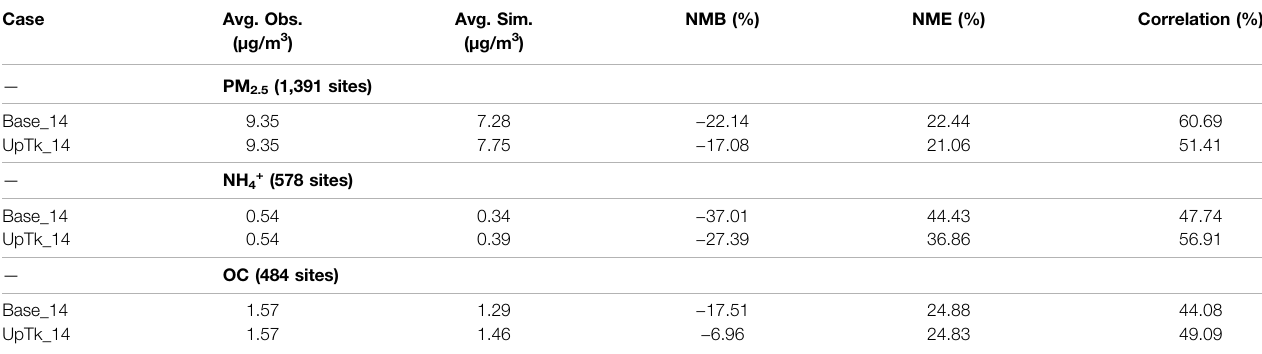
TABLE2| ModelperformancestatisticsforPM 2.5 ,NH 4+ ,andOrganicCarbon(OC)underdifferentscenarios.PM 2.5 andOCobservation(Obs.)dataarefromthreenetworks (IMPROVE,CSNandAQS);NH 4+ observationdataarefromfournetworks(IMPROVE,CSN,CASTNET,andAQS).(Average — Avg.;Simulation — Sim.;NormalizedMean Bias — NMB; Normalized Mean Error —